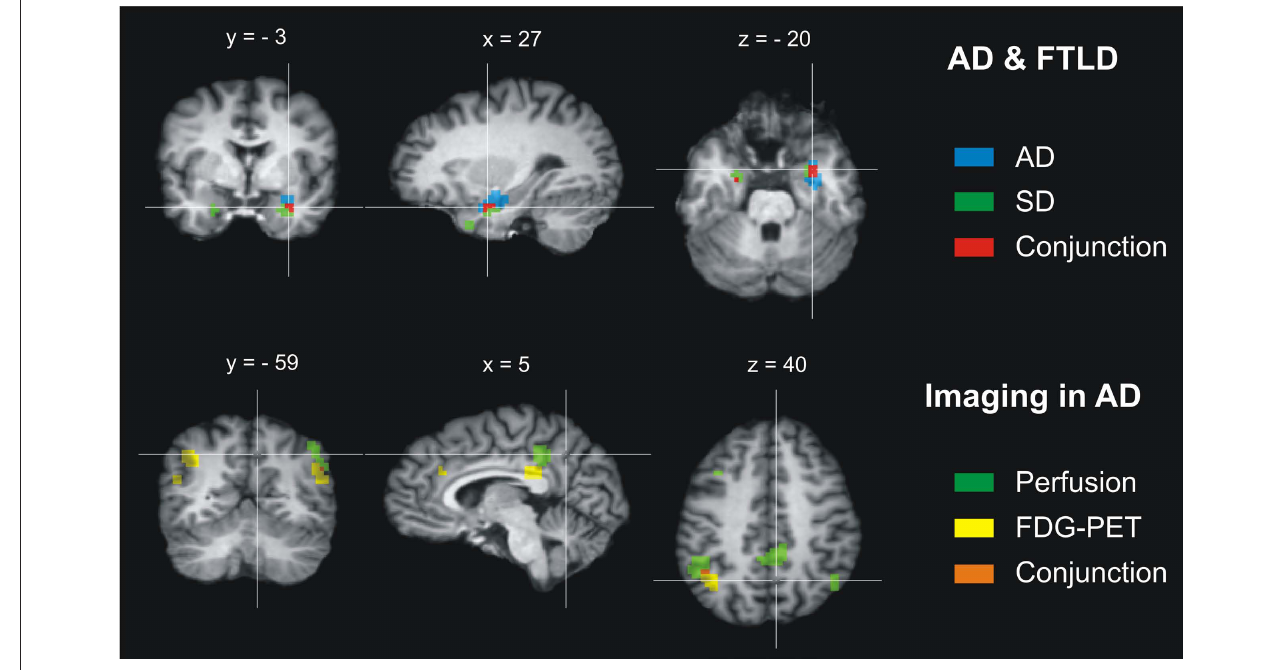
FIGuRE 2 | Results of the conjunction analysis for Alzheimer’s disease (AD) and frontotemporal lobar degeneration (FTLD). Upper row : Atrophic brain regions overlap in AD and the FTLD subtype semantic dementia (SD) in both amygdalae and hippocampal heads (maximum/cluster size: left − 26 − 9 − 18/27 mm 3 , right 25 0 − 21/243 mm 3 ). No further overlap of atrophy (MRI) or changes in glucose utilization (FDG-PET) was found for AD and the three FTLD